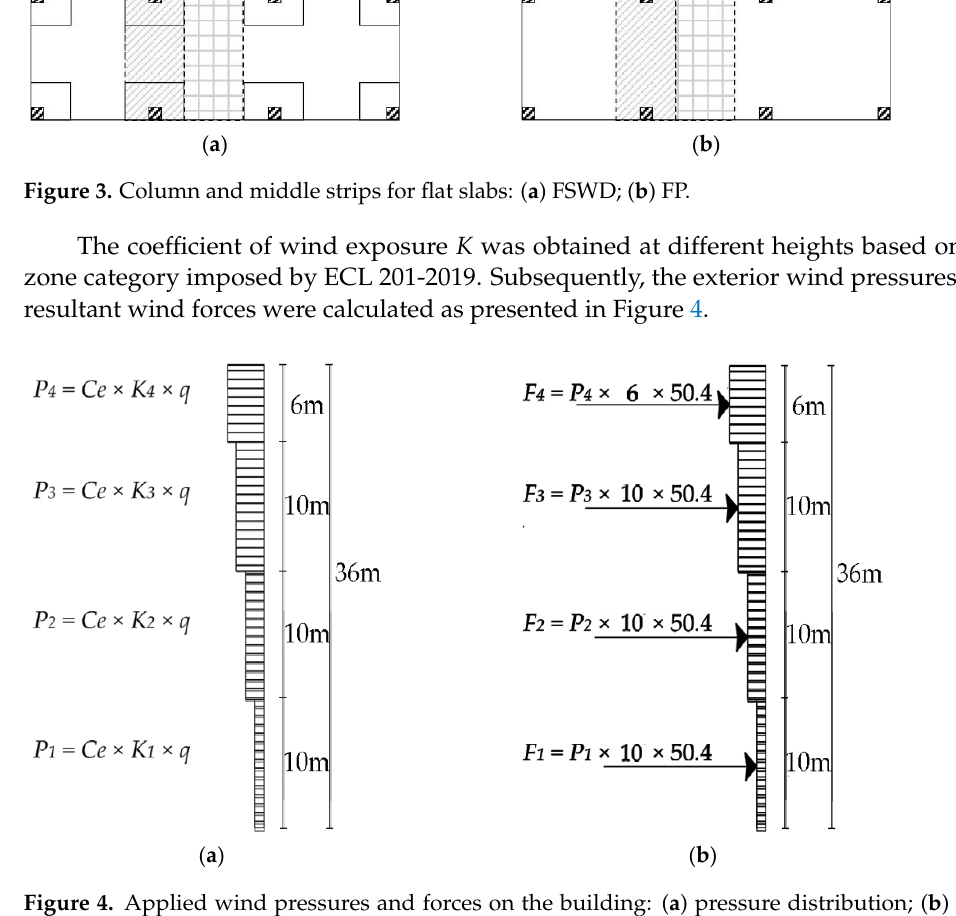
Figure 3. Column and middle strips for flat slabs: ( a ) FSWD; ( b ) FP.